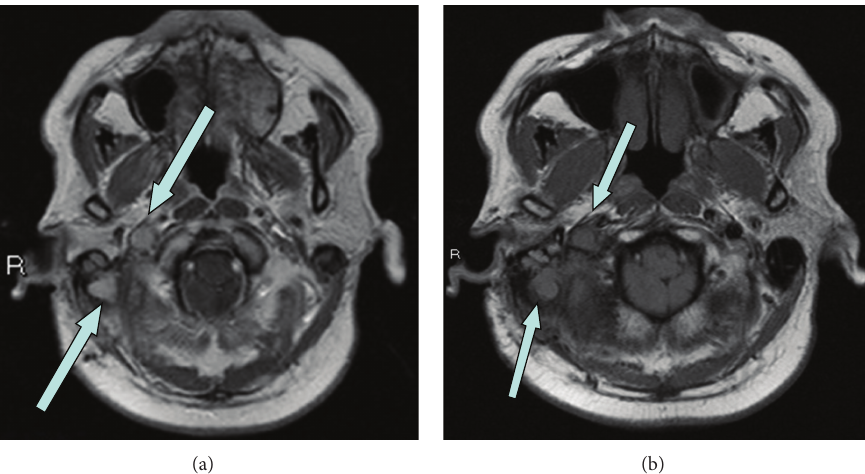
Figure 1: Pre- and postcontrast axial T1 weighted images show an enhancing mass in the region of the right sigmoid plate and sinus. There is an enhancing component involving and enlarging the right internal jugular vein.